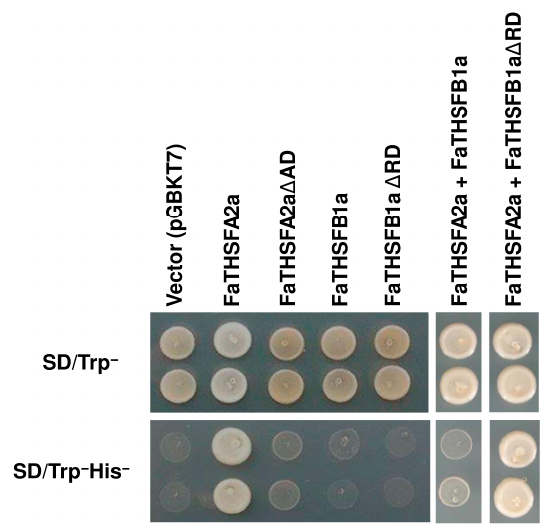
Figure 8. Analysis for measuring trans-activation activity in yeast cells. The full-length constructs of FaTHSFA2a and FaTHSFB1a were fused to GAL4 DBD and expressed in the yeast strain AH109. The transformed yeast cells were grown in non-selective media with histidine (SD/Trp − ) or selective media without histidine (SD/Trp − His − ), followed by incubation at 30 °C for 3 days. Two independent transformants were selected from each construct in the presence of histidine (SD/Trp − ). Subsequently, yeast cells containing either single construct or cotransformed constructs were spotted on the media with (SD/Trp − ) or without histidine (SD/Trp − His − ). The pGBKT7 vector transformed into yeast cells was used as the negative control.